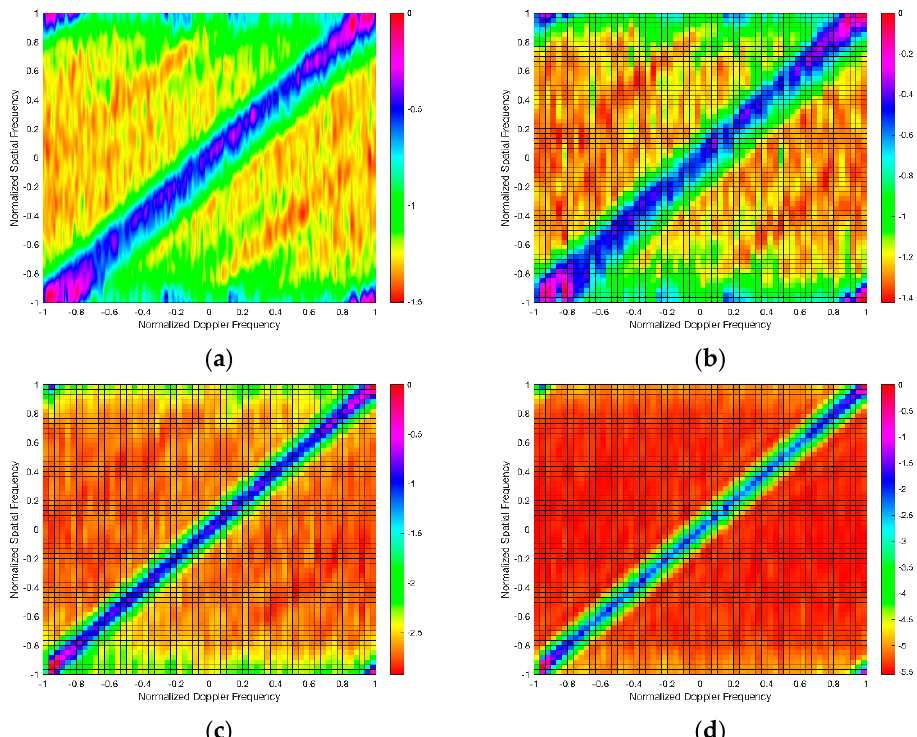
Figure 3. Spatial–temporal clutter spectra in scene 2 using the ( a ) Full–STAP, ( b ) SR–STAP, ( c ) CM– STAP, and ( d ) proposed algorithms.